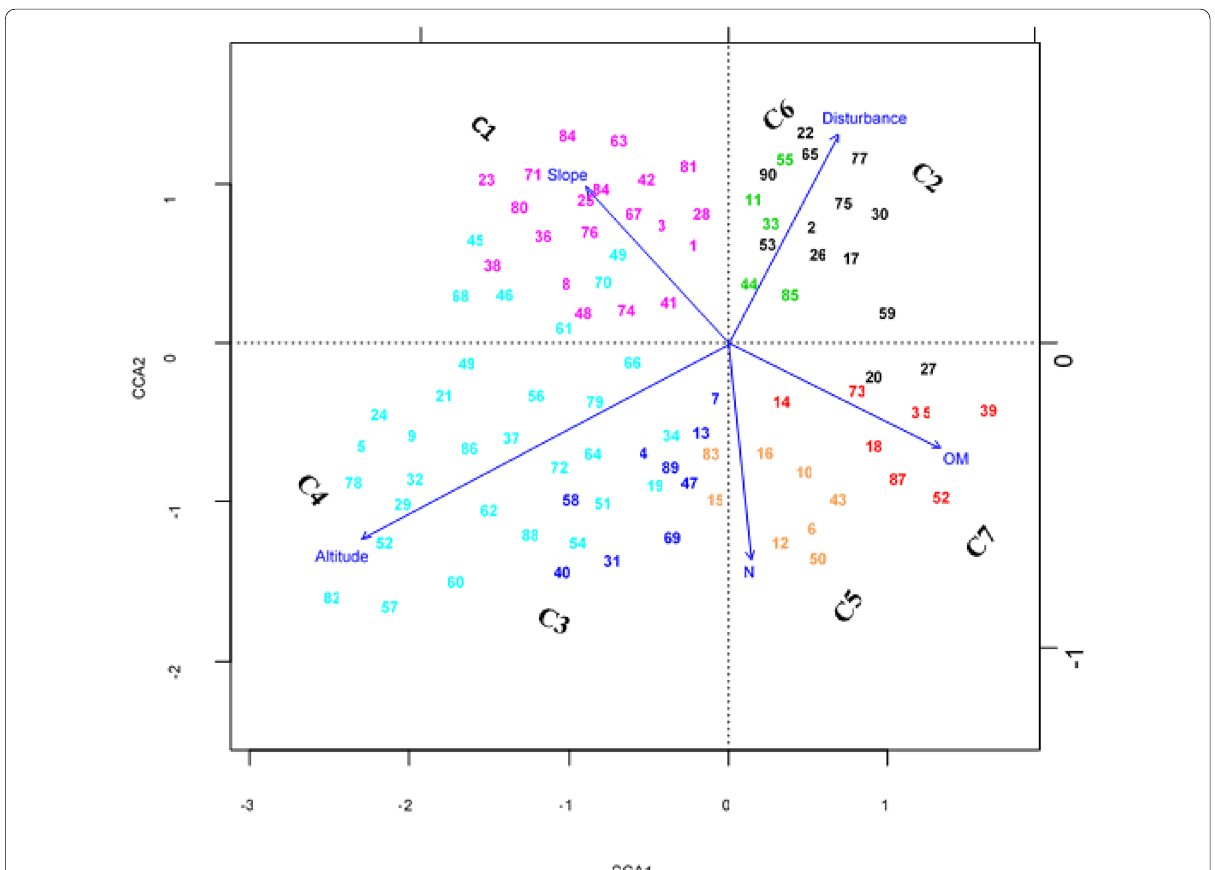
Fig. 9 CCA showing the relationship of the environmental factors among themselves and on the distribution of plants in the study area (Numbers inside the ordination diagrams represents plot numbers; and C denotes community number; arrows representing environmental variables; and arrow length shows the strength of the environmental